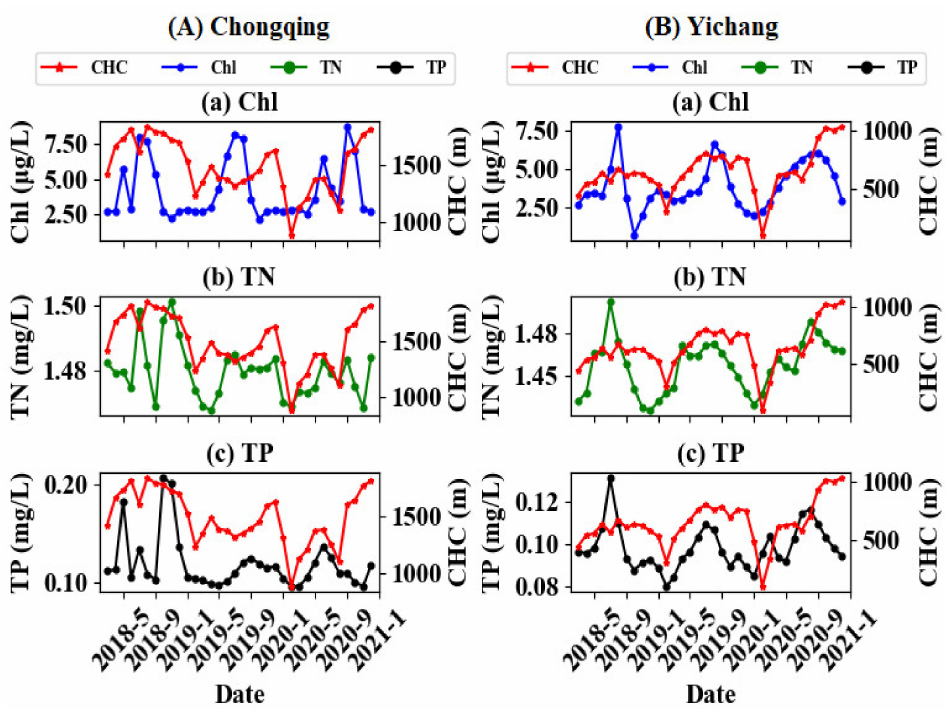
Figure 13. Variations in the Cargo handling capacity and the Chl-a concentrations of rivers from 2018 to 2020 in ( A ) Chongqing and ( B )